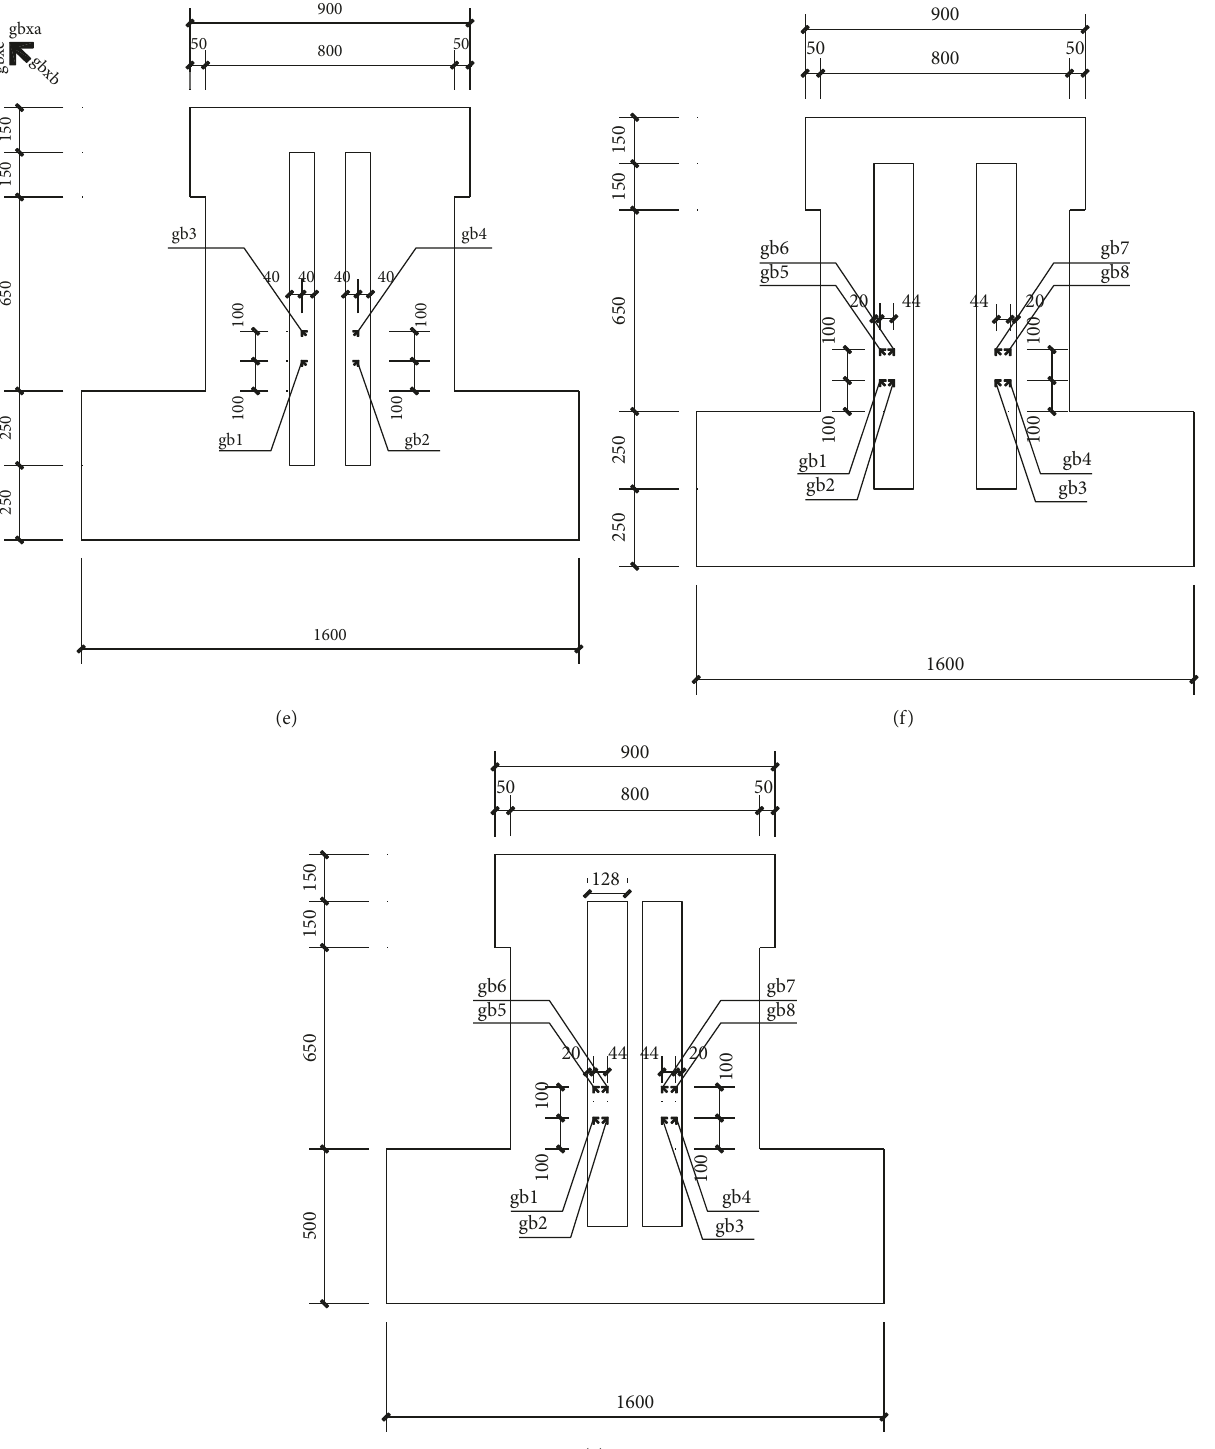
Figure 5: Strain measuring point layouts. (a) Cold-rolled section steel strain measuring points. (b) Edge component longitudinal bar strain measuring points. (c) Horizontally distributed bar strain measuring points. (d) SPRCW-5 steel plate strain measuring points. (e) SPRCW-6 steel plate strain measuring points. (f) SPRCW-7 steel plate strain measuring points. (g) SPRCW-8 steel plate strain measuring